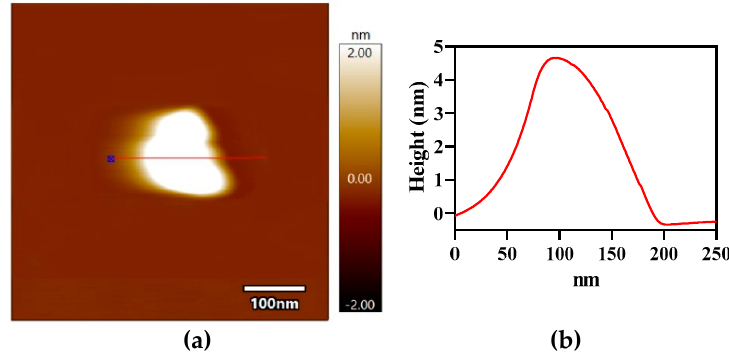
Figure 5. (a) AFM image and (b) corresponding line profile of the P10% Fe sample. Figure 5. AFM image of the P10% Fe sample with corresponding line